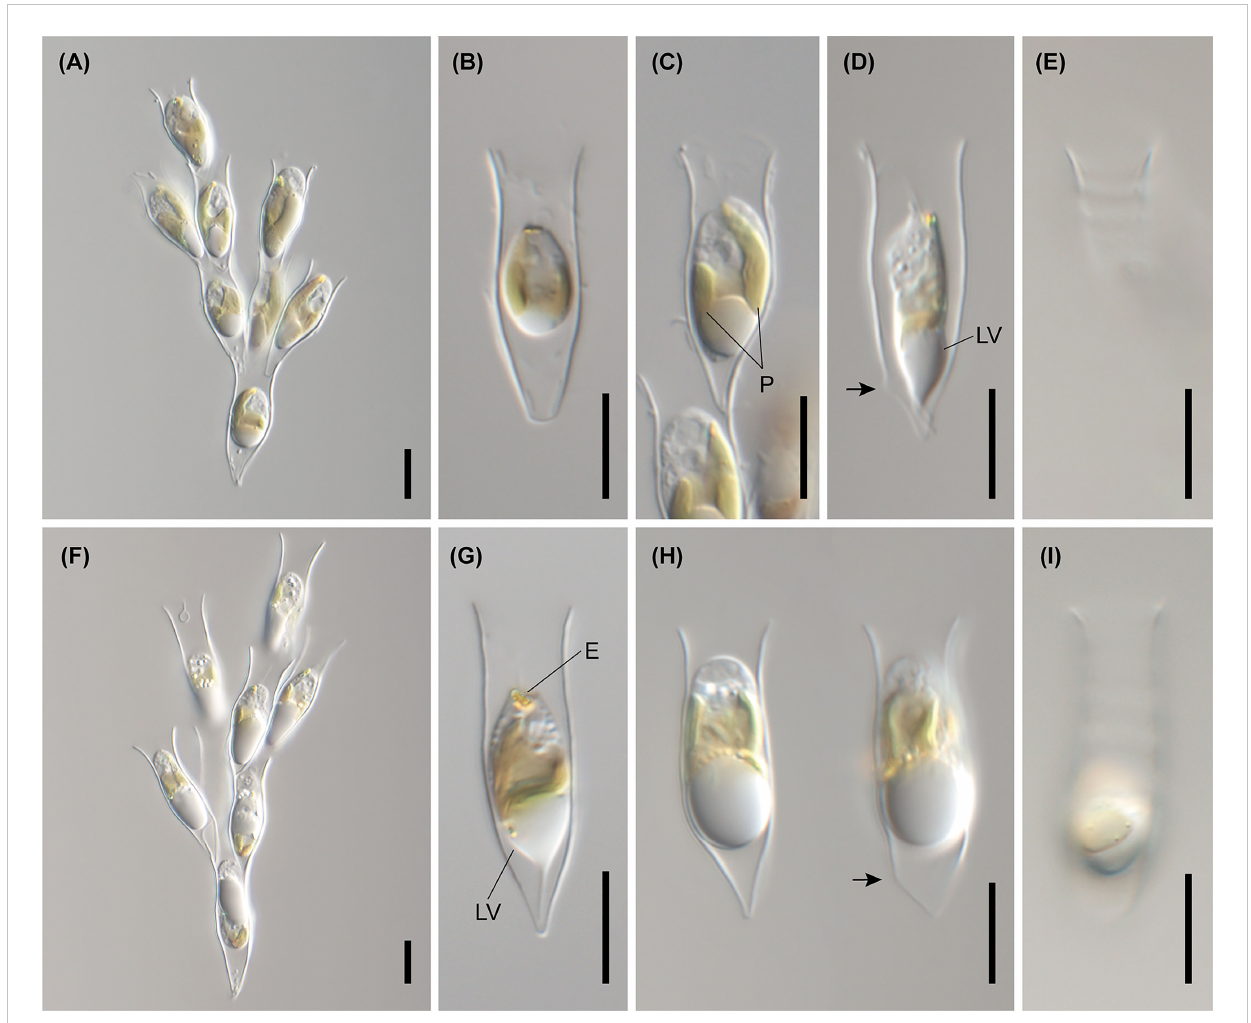
FIGURE 8 Light micrographs of Dinobryon species. (A – E) Images of D. spinum Geumgok020610D. (F – I) Images of D. sertularia var. thyrsoideum Chosan041710C. An irregular protuberance is in one side of the lower lorica part (arrow). E, eyespot; LV, leucosin vesicle; P, plastid. Scale bars = 10